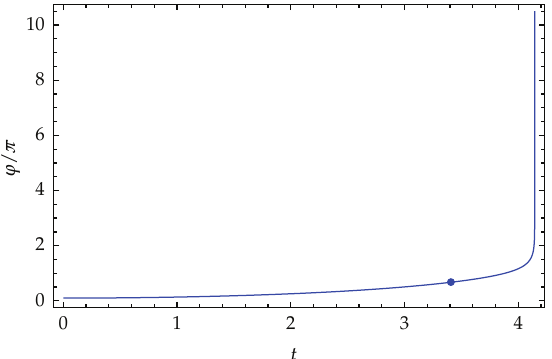
Figure 4: ϕ/π versus t/t 0 . The dot indicates the value ϕ/π (cid:9) 0 . 67 at t ∗